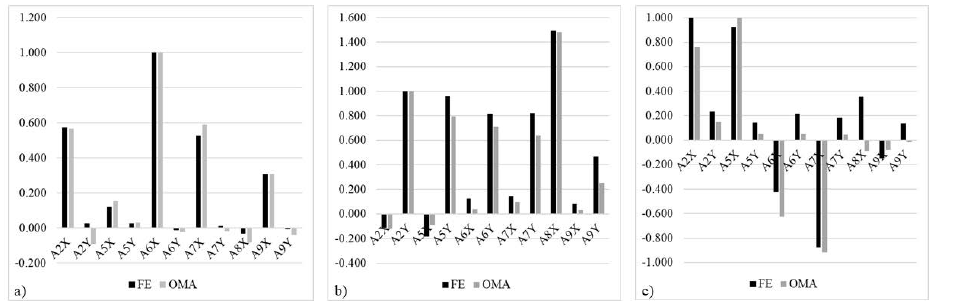
Figure 8. Comparison between FEM and Operational Modal Analysis (OMA): ( a ) Mode shape 1, ( b ) Mode shape 2 and ( c ) Mode shape 3.